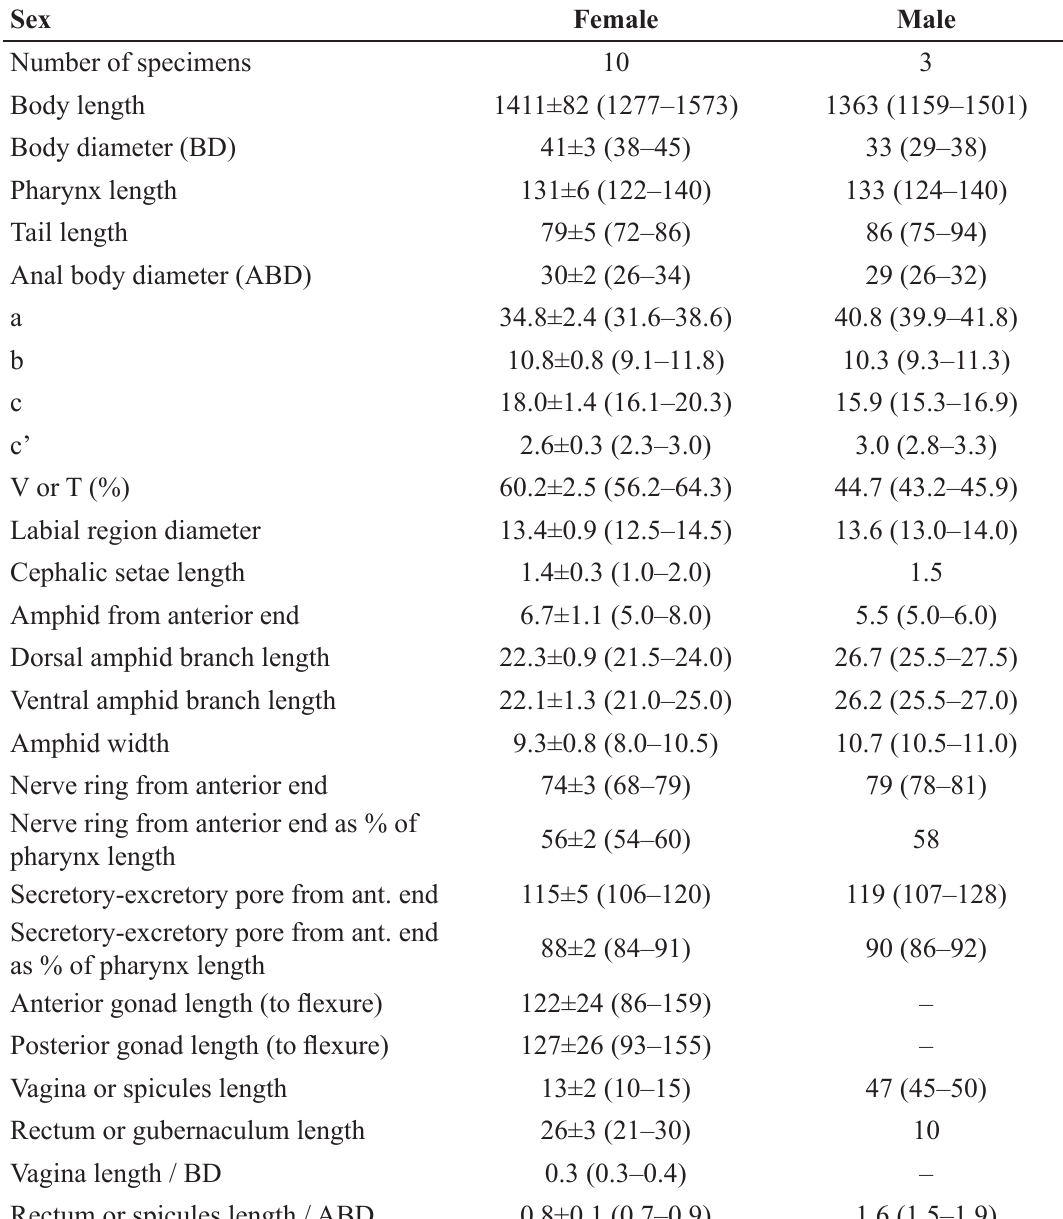
Table 3. Measurements (in µm) of Diplopeltoides bulbosus (Vitiello, 1972) comb. nov., presented as mean±s.d. (standard deviation) and (range) or mean and